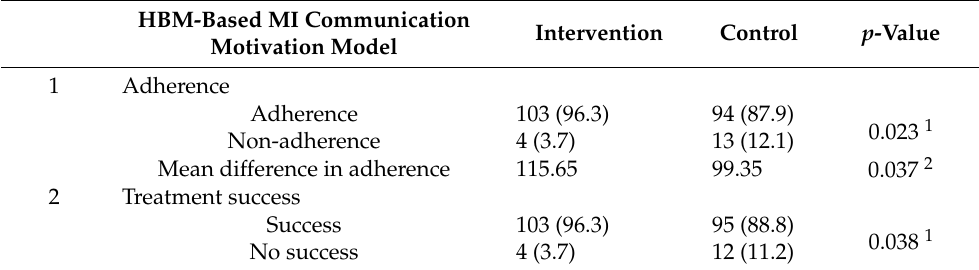
Table 2. Comparison of effects of HBM-based MI communication motivation counseling on medica- tion adherence and treatment success between groups.